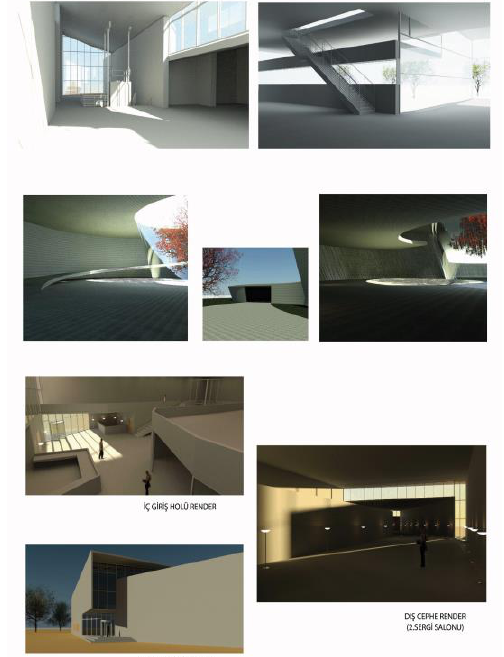
Figure 3 : Sample BIM model renders given to express the solar conditions of the 3 rd semester students’ final design studio projects.